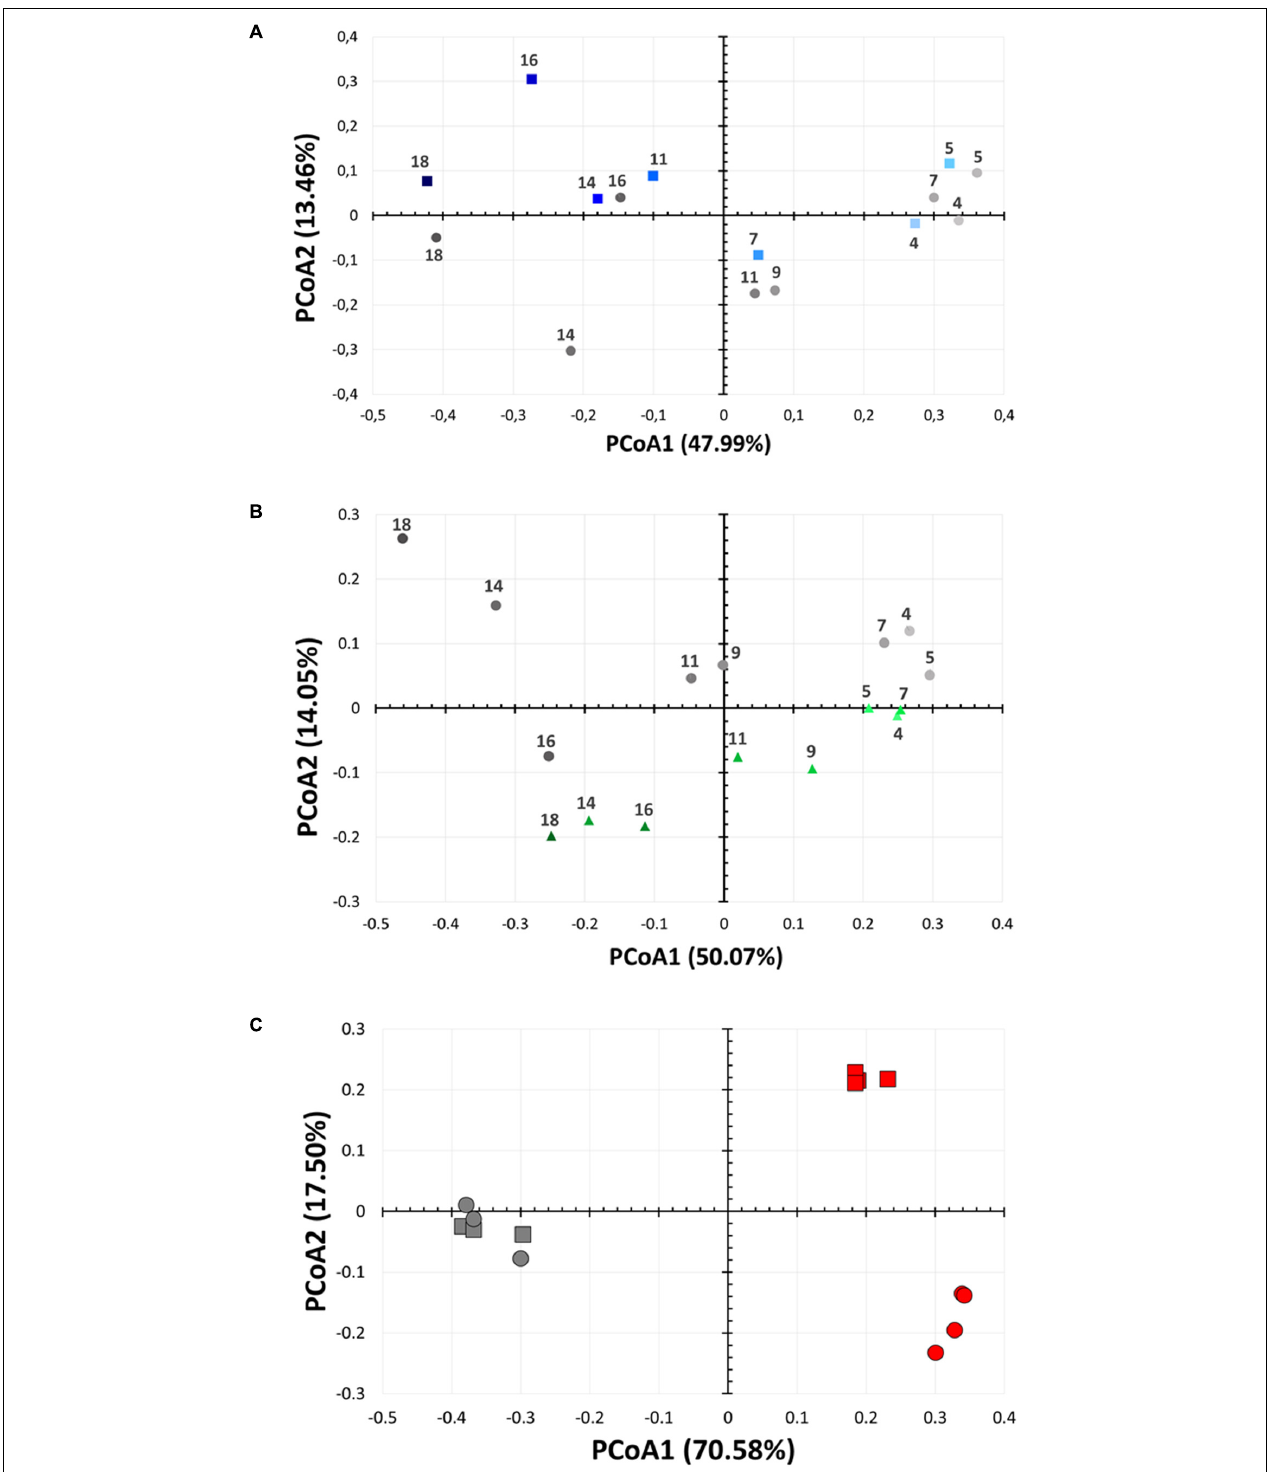
FIGURE 5 | Bacterial community changes as a function of lactonase concentration and time. Principal coordinate analysis of microbial biofilm communities from the bioreactors over time (from day 4 to day 18). Analysis are performed for (A) the 2 × lactonase (blue squares) and control communities (gray circles) and (B) the 1 × lactonase (green triangles) and control communities (gray circles). (C) Principal coordinate analysis of suspension microbial communities from a small scale suspension culture in presence (red) or absence (gray) of active lactonase. Data ( n = 4 replicates) for days 3 and 7 are shown as squares and circles, respectively. Control group ( n = 3 replicates) was treated with the inactive mutant SsoPox